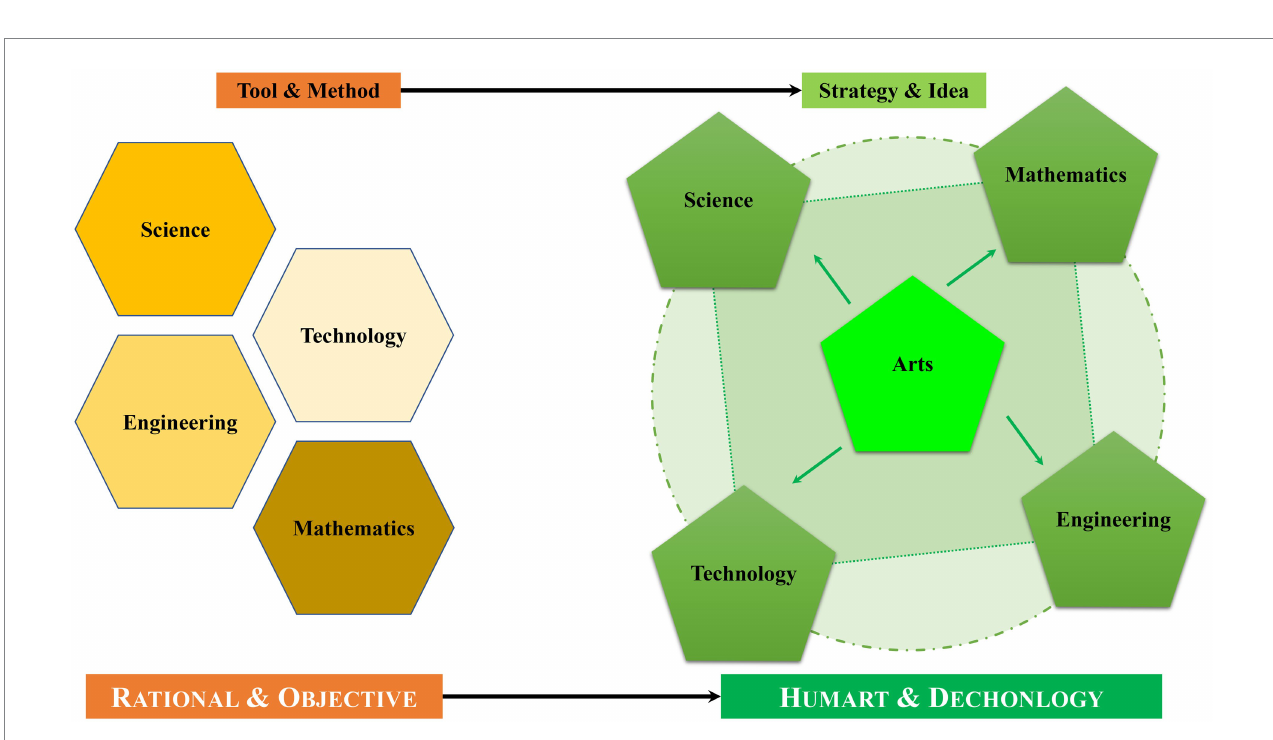
FIGURE 2 From STEM to STE(A)M: Humarts + Dechnology (Source: this